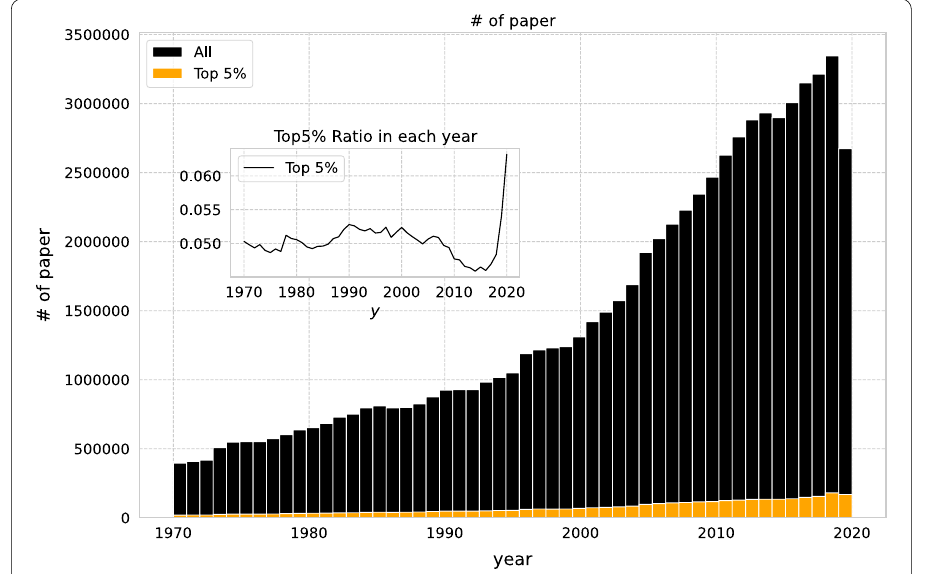
Fig. 2 Publication year of papers. The black bar shows the whole number of papers published in the year. The orange bar represents the top5% in citation normalised by the average number of citations of papers submitted in the same field in the same year (Radicchi et al. 2008). The small graph shows the proportion of top papers to the total number of papers submitted in each year, which was stable at around 0.05 for